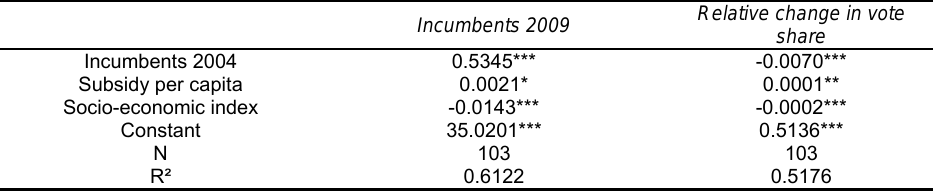
Table 2: Results with subsidies per